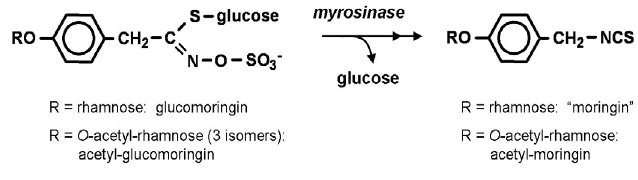
Fig. 1: Structure of the M. oleifera glucosinolates and the related isothio-